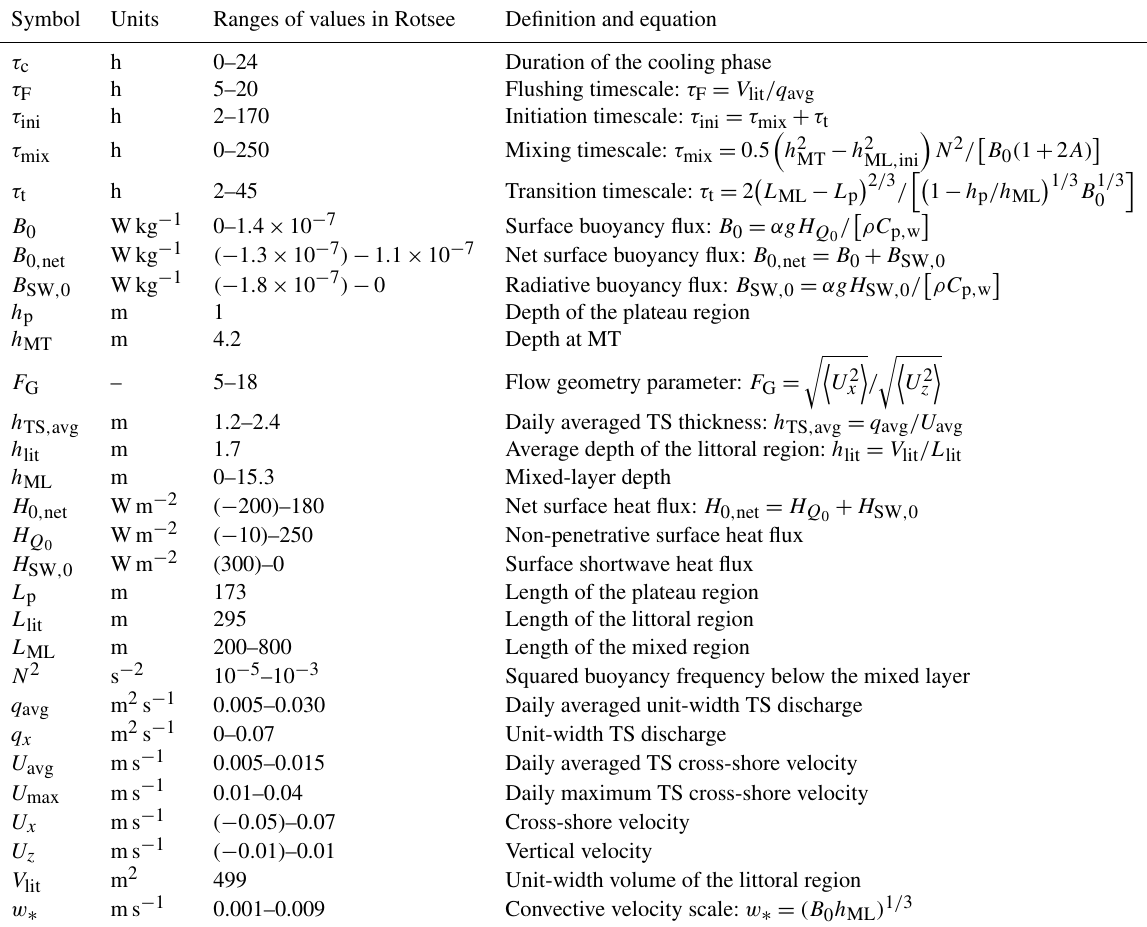
Table 1. Key parameters related to the forcing parameters, bathymetry, and TS dynamics. For seasonally varying parameters, the given ranges of values are daily